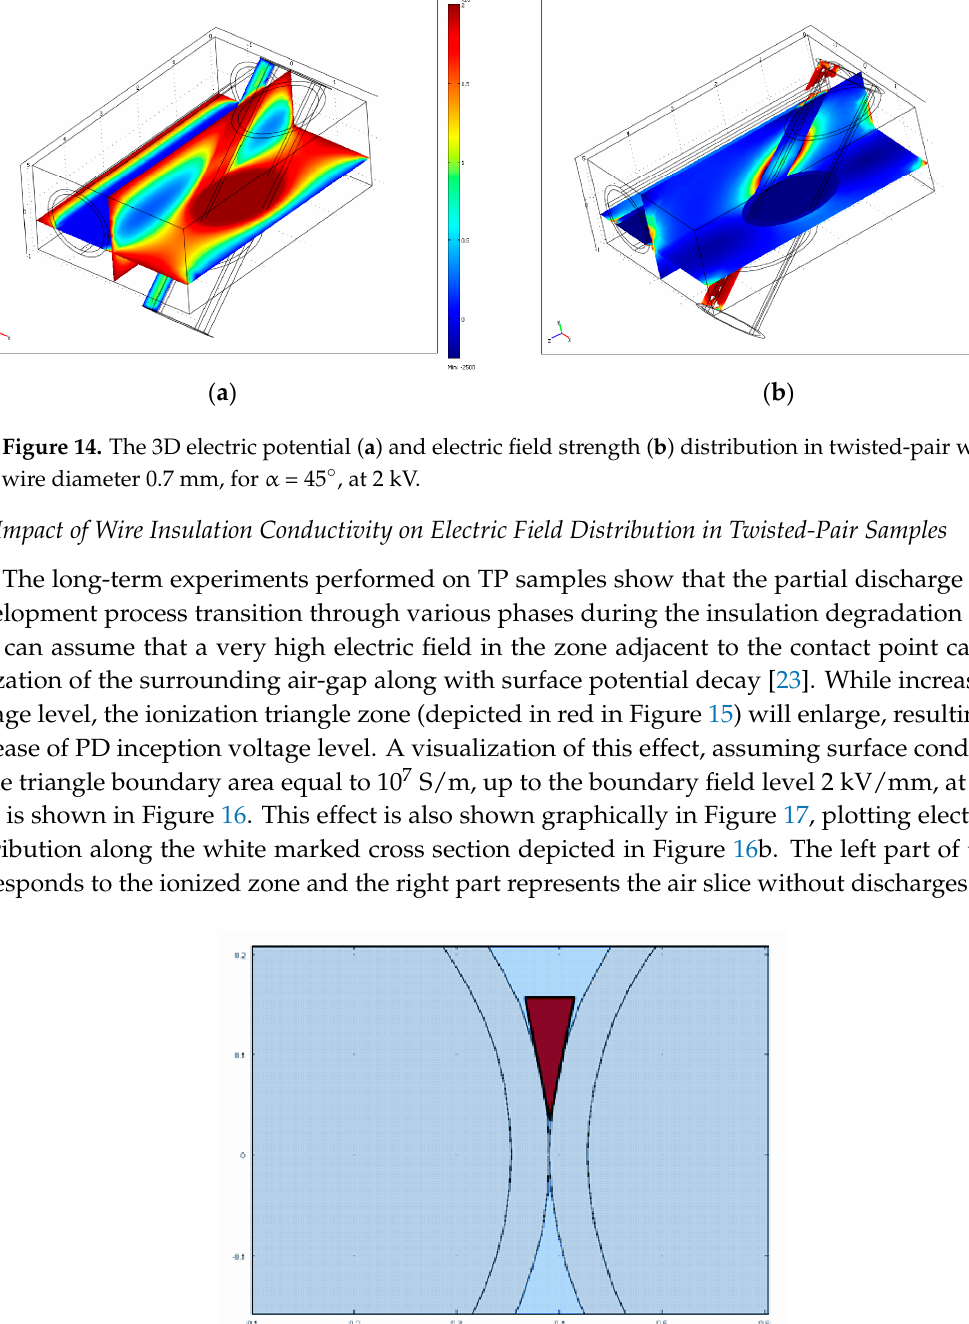
Figure 15. Visualization of the ionization zone and variable surface conductivity area.